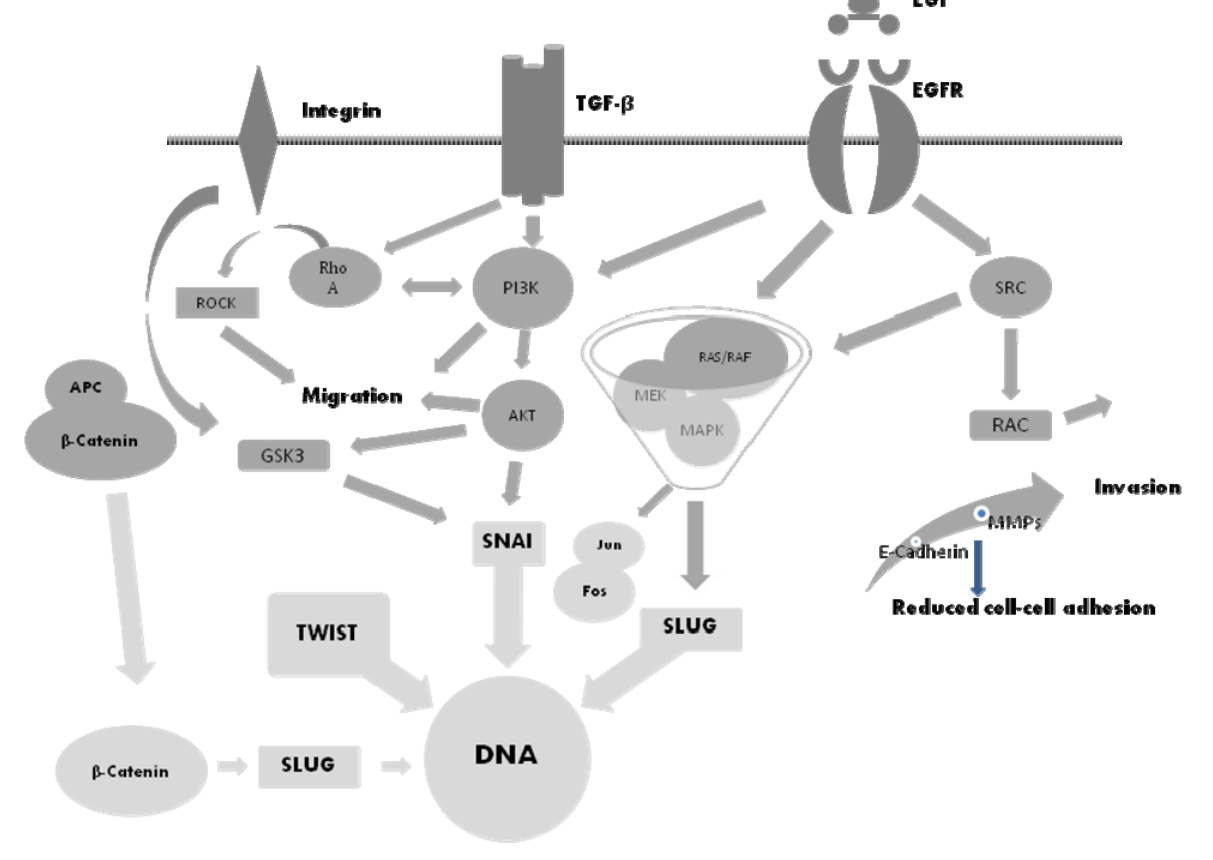
Figure 1. Representation of the signal transduction pathways associated with